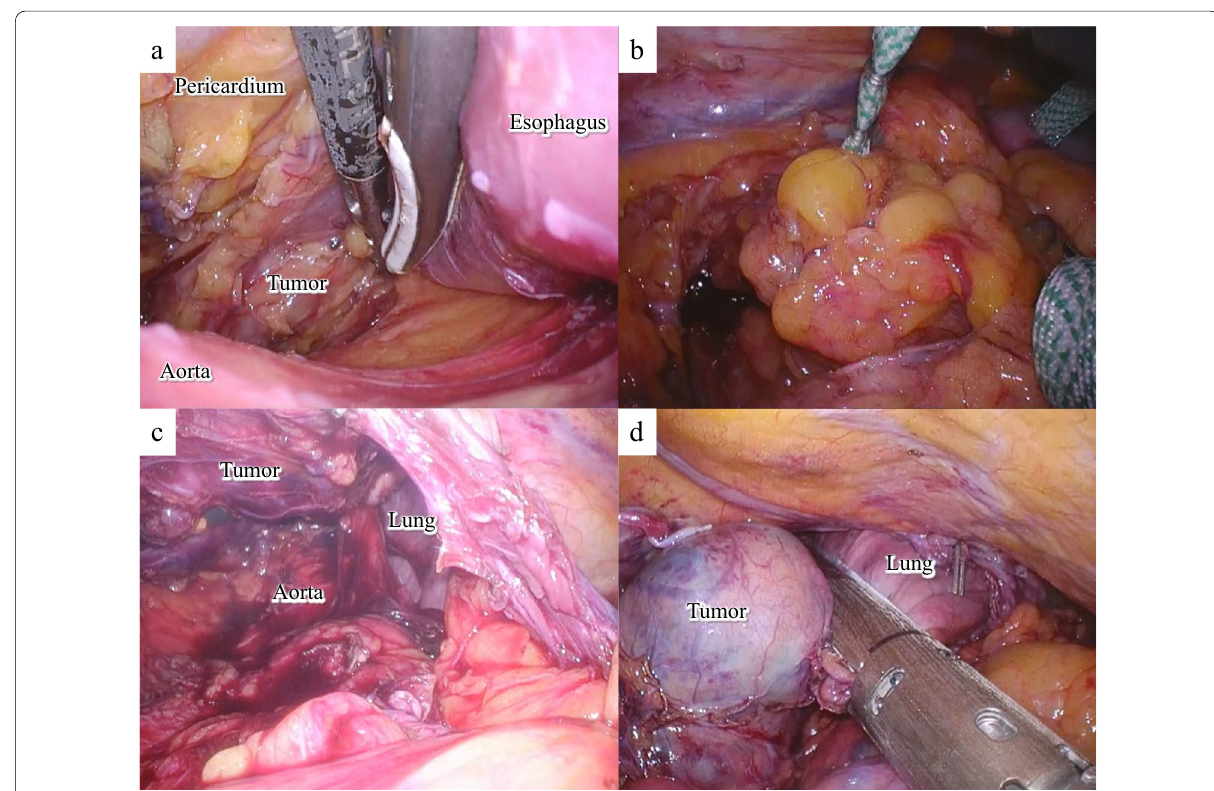
Fig. 3 Using a mediastinoscope, the upper and middle thoracic esophagus is dissected from the surrounding tissue without lymph node dissection ( a ). A laparoscopic incision of the left diaphragm provides a clear image of the left thoracic cavity ( b , c ). The tumor is completely resected along with part of the lower lobe of the left lung using linear stapler ( d